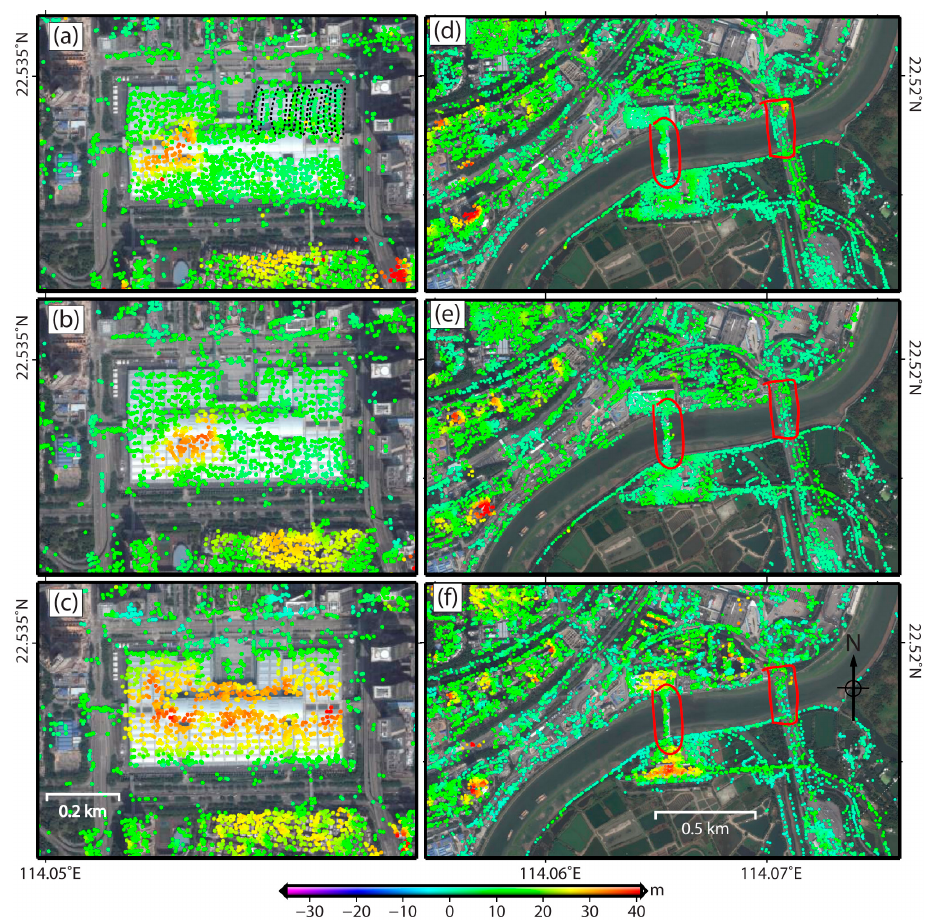
Figure 15. Height value of the selected PSs of two selected areas in map coordinate: ( a – c ) Area 1 locates at SZCEC; and ( d – f ) Area 2 locates around Futian Port. The background is the optical image derived from Googleearth. ( a , d ) The elevation and distribution of selected PS with SRTM-1arc DEM in multi-look geocoding operation. ( b , e ) The elevation and distribution of selected PS with SRTM-1arc DEM in single-look geocoding operation. ( c , f ) The elevation and distribution of selected PS with TanDEM-X DEM in single-look geocoding operation. The dashed lines in ( a ) represent the regular building structures, i.e., cross girder. The red lines in ( d – f ) represent the linear feature, i.e.,